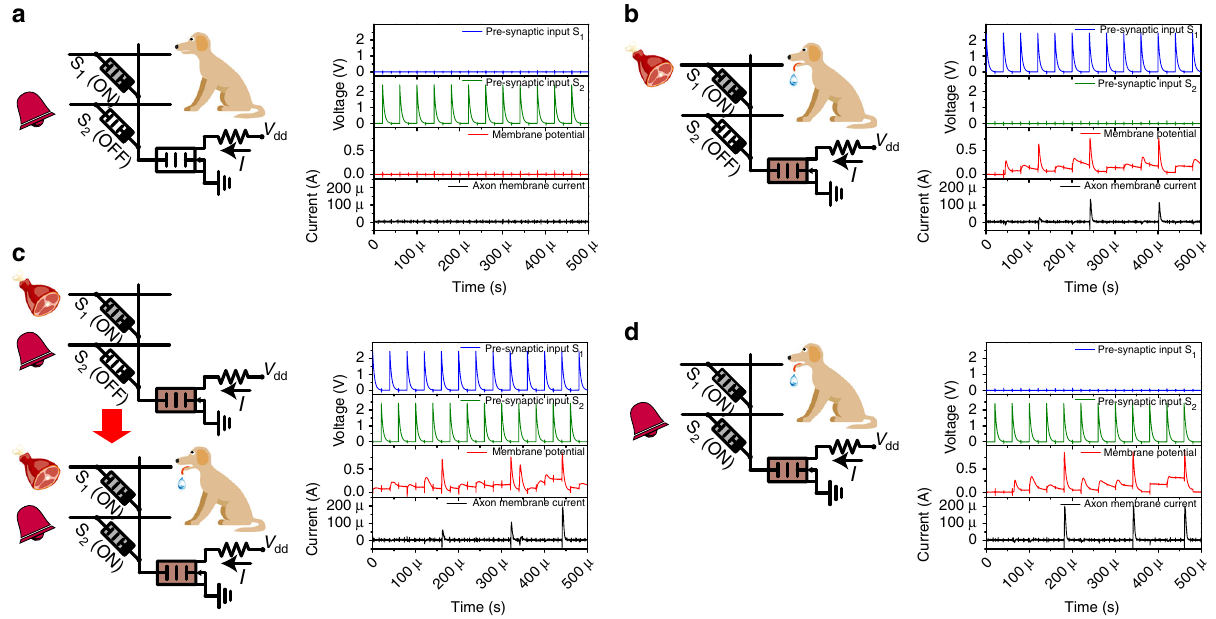
Fig. 3 Capacitive network for associative learning based on the Hebbian-like mechanism. Two pre-synaptic signals model the sight of food and the sound of a bell, respectively. The post-synaptic neuron models the salivation of a dog. The initial weight of the synapse interfacing with the “ food ” pre-synaptic neuron was large, while that of the synapse connected to the “ bell ” pre-synaptic neuron was small. a Probing with only the “ bell ” signal before association. The post-synaptic neuron did not fi re. b Probing with only the “ food ” signal triggered the fi ring of the post-synaptic neuron. c Associative learning with simultaneous “ bell ” and “ food ” stimuli applied for a suf fi cient time. If the relaxation time after fi ring of the “ salivation ” pre-synaptic neuron was long enough, the backpropagating signal could overlap with the forward propagating voltage spikes from the “ bell ” neuron, which programmed the non- volatile pseudo-memcapacitor (NPM)-based “ bell ” synapse. d Probing after the conditioning phase. The post-synaptic neuron fi red with only the “ bell